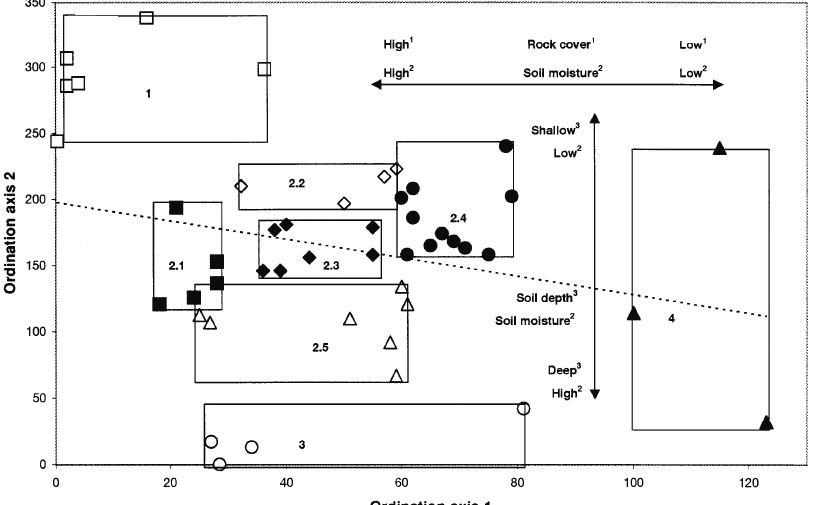
Fig. 2. Relative positions of all the relevés of the semi-arid savanna of the Sekhukhuneland Centre along the first and second axis of an ordination. Numbers correspond with the plant communities in Table